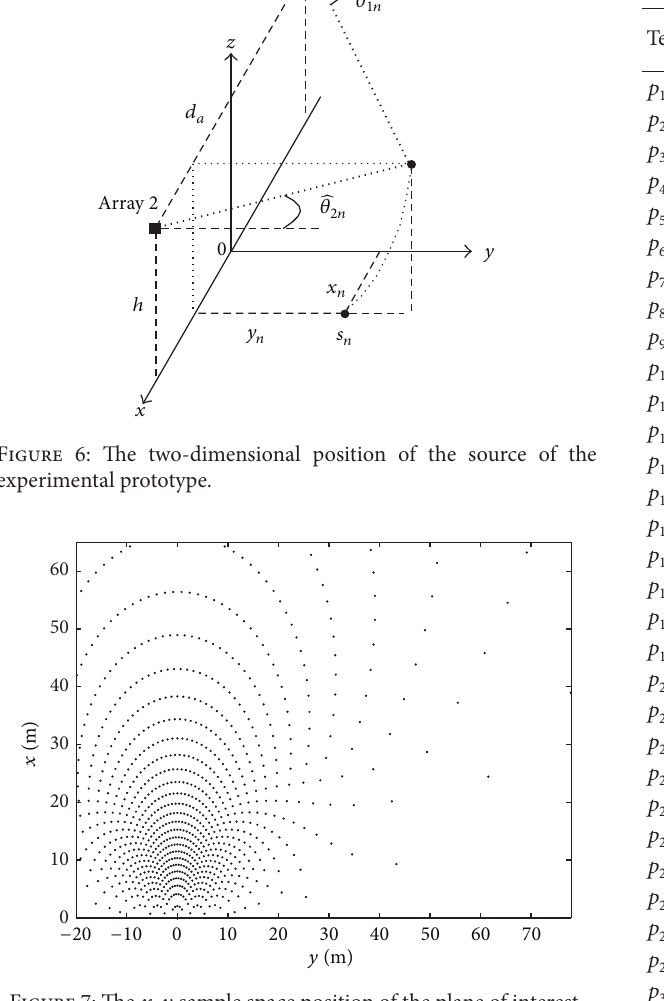
Figure 7: The 𝑥 - 𝑦 sample space position of the plane of interest.